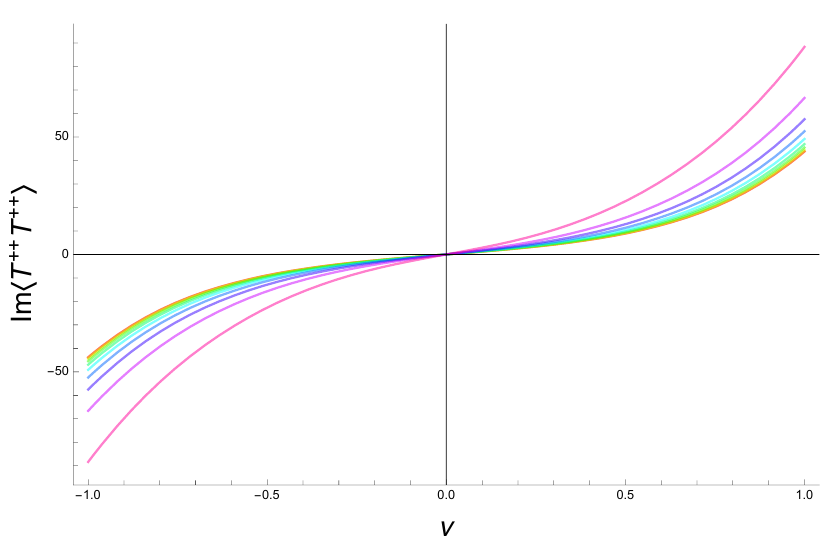
Figure 13 . Numerical result for Im h T ++ T ++ i displayed as a function of (cid:23) , where the color encodes the values of a in the range 0 < a < 1. Red is the lower bound while purple is the higher